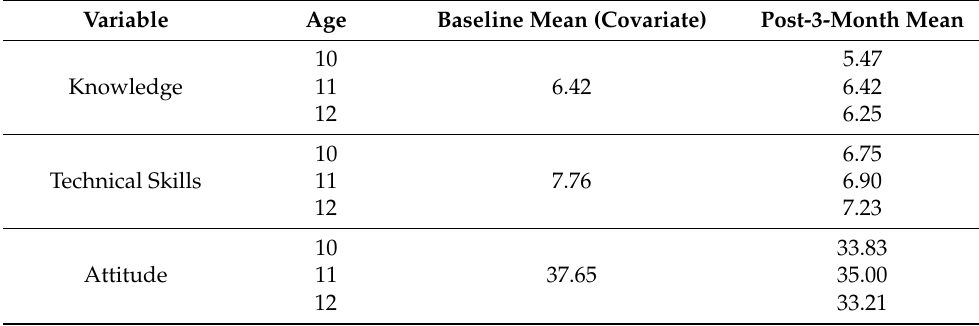
Table 5. Estimated marginal means of knowledge, technical skills, and attitude towards CPR among students 3 months following the